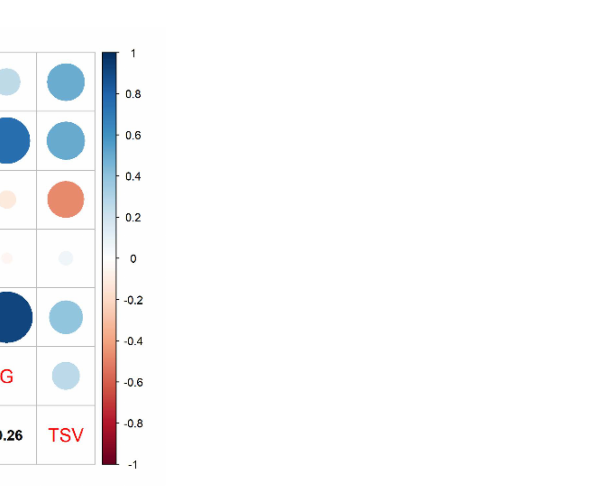
Figure 10. Physical factors affecting TSV (blue represents positive correlations, red represents negative correlations. Numbers indicate correlation coefficients. The color shade and circle size represent the strength of the